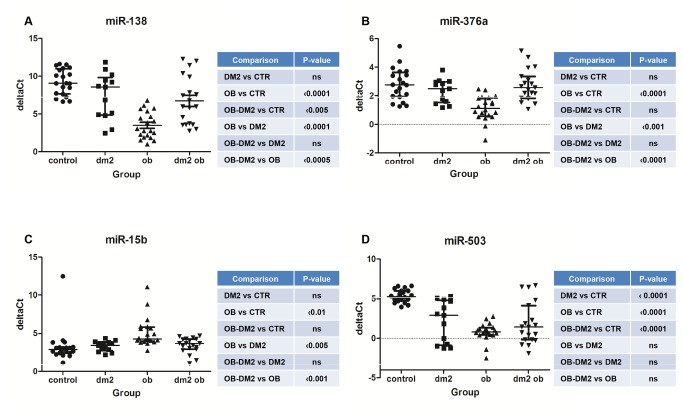
Comparison of the serum levels of miR-138(A), miR-376a (B), miR-15b (C) and miR-503 (D) in controls, DM2, OB and OB-DM2 groups.Graphs show median level with interquartile range. The Kruskal-Wallis test with Dunn´s post test was used to determine the significance of differences between groups. The serum levels were determined using RT-PCR following RNA extraction. Two technical replicates were performed on two cDNA replicates.